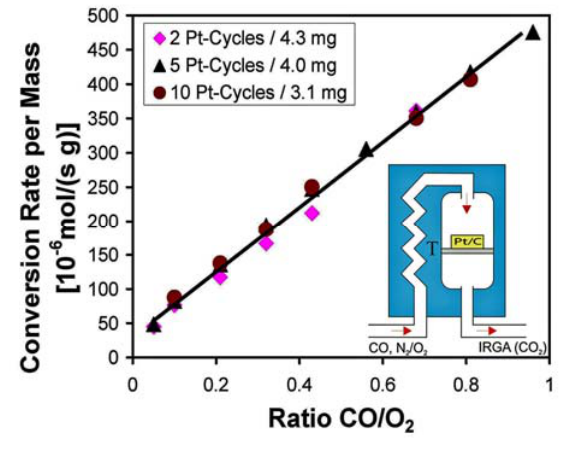
Figure 13. CO conversion rate (normalized with respect to the catalyst mass) as a function of the CO content in the feed for various loading levels. The maximum activity is reached after only two cycles of